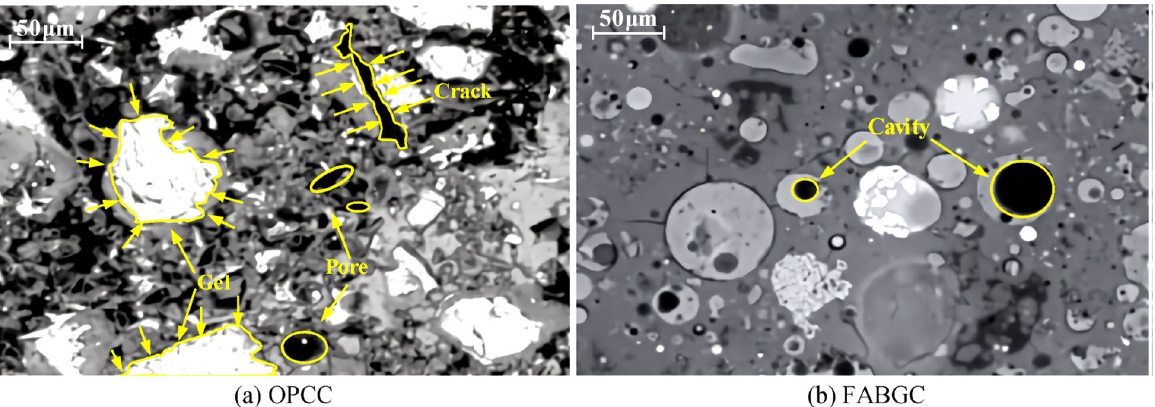
Figure 27. SEM images of the binders and ITZs of ( a ) PCC and ( b ) FA ‐ GP concrete. Adapted from [172,259,265].